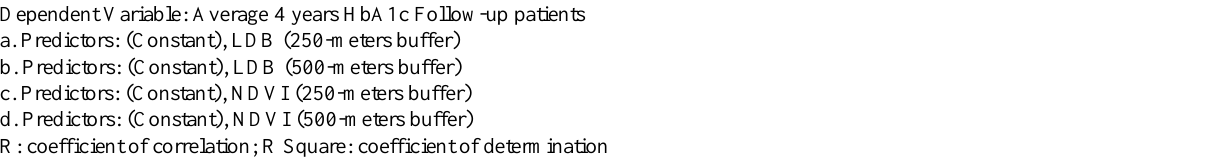
Table 3. Linear regression models